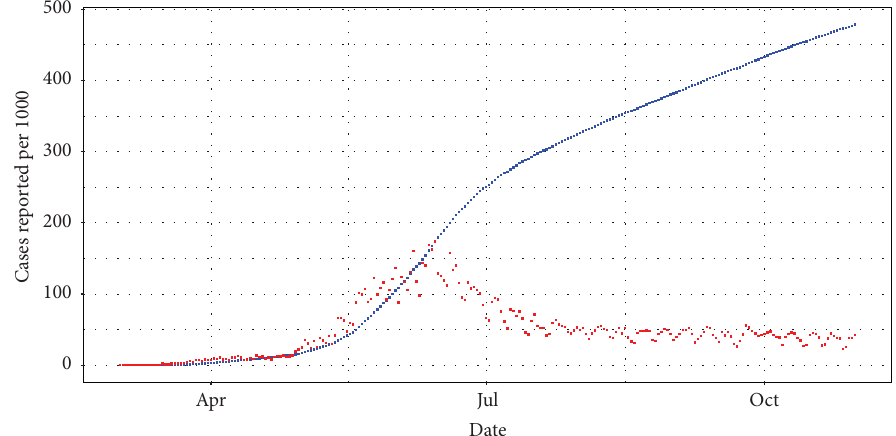
Figure 1: Cumulative and daily number of infected by COVID-19 in Chile from March 2 to October 31, 2020. Cumulative infected cases are shown in blue. In red, the daily cases amplifed in an appropriate amount are recorded in order to better appreciate